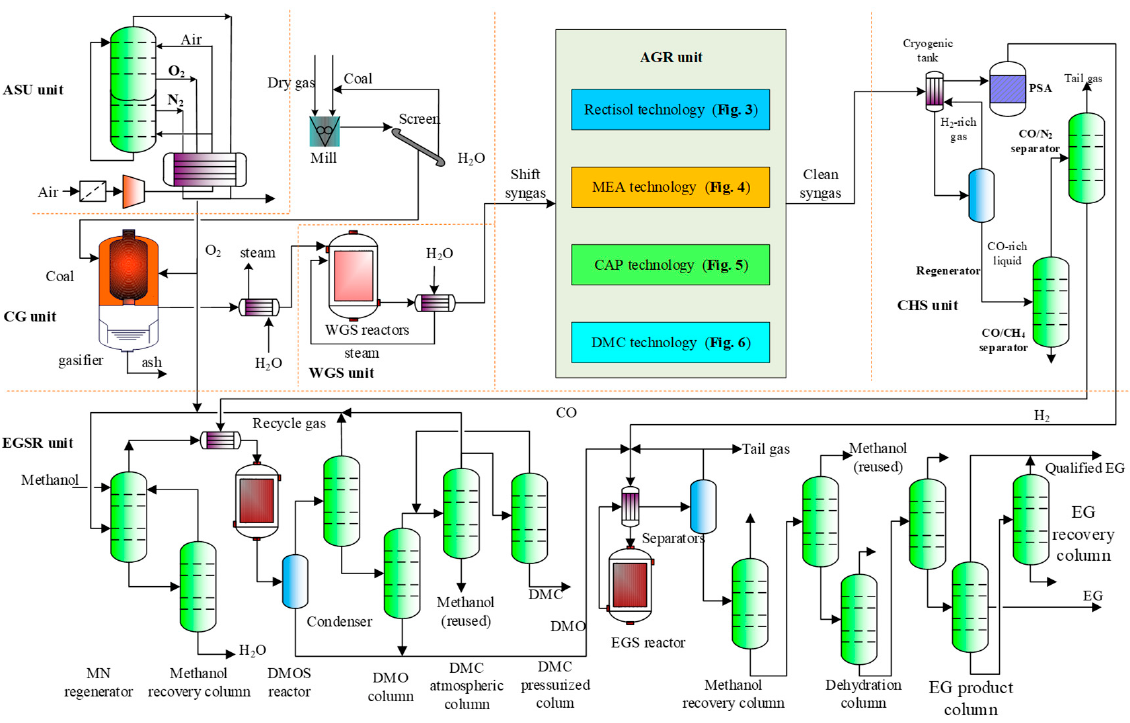
Figure 7. Simplified simulation flowsheet of CTEG process with different CO 2 capture technologies. Table 2. Key parameters for modeling and simulation of four CTEG processes. Unit